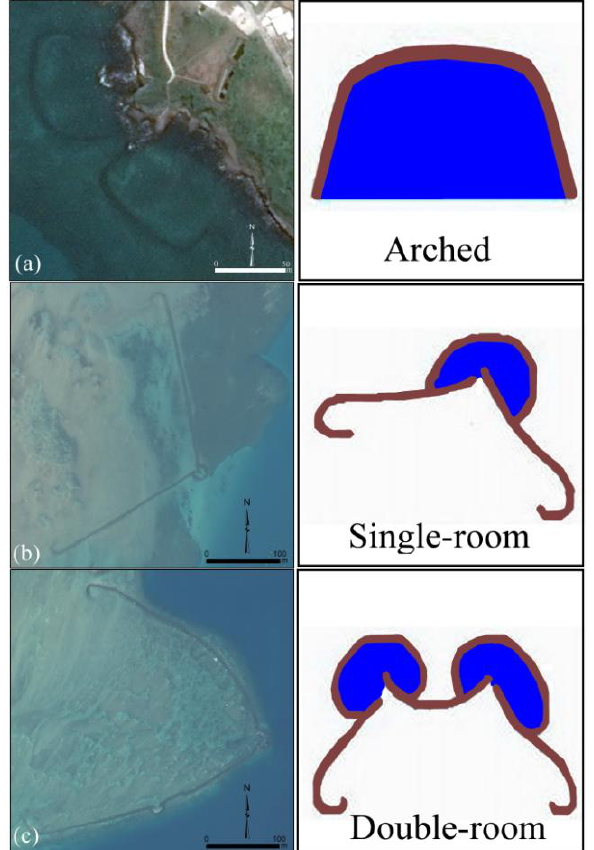
Figure 2. The left panel shows GoogleEarth images (© GeoEye Image Copyright 2015, DigitalGlobe) of three typical STWs, and the right panel shows schematic views corresponding to the left images: a-Arched, b-Single-room,